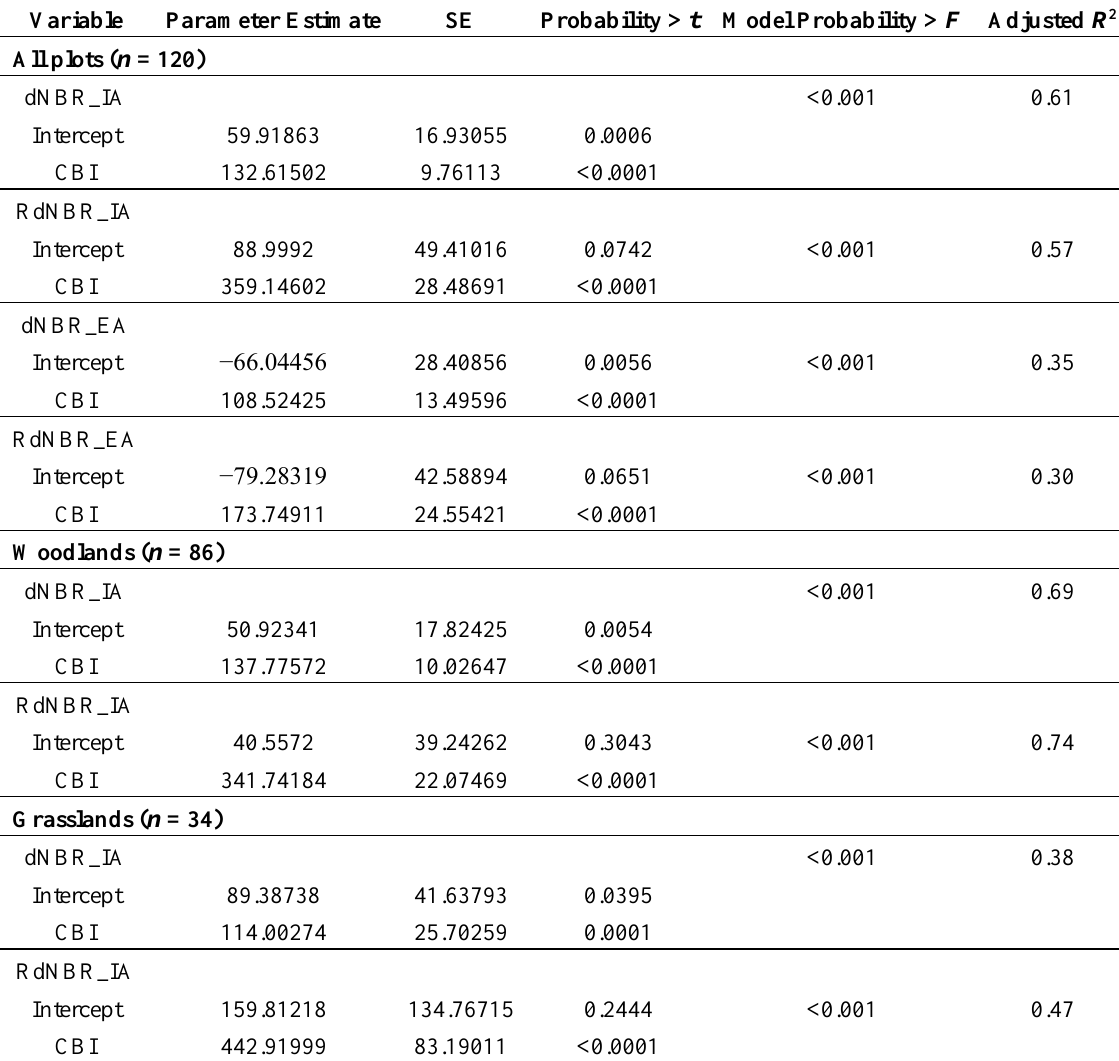
Table 3. Regression models of remotely sensed burn ratios and the composite burn index